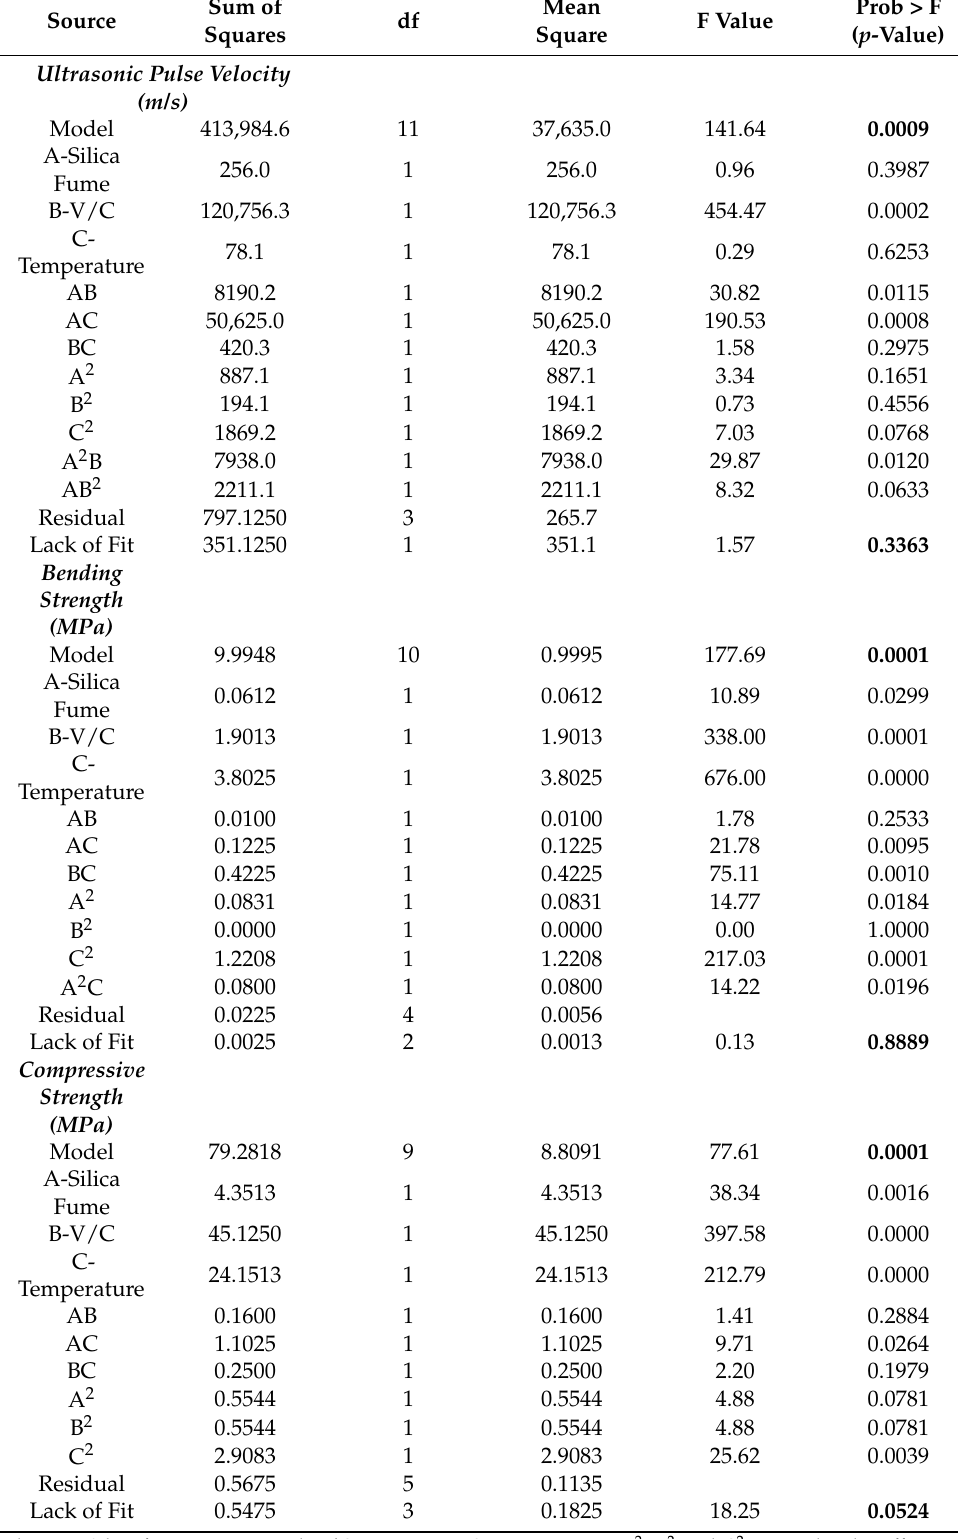
Table 5. ANOVA for developed response